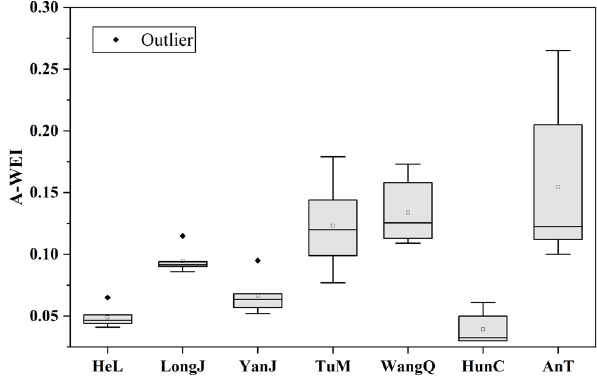
Figure 8. Comparison of agricultural water use efficiency in TRB regions.